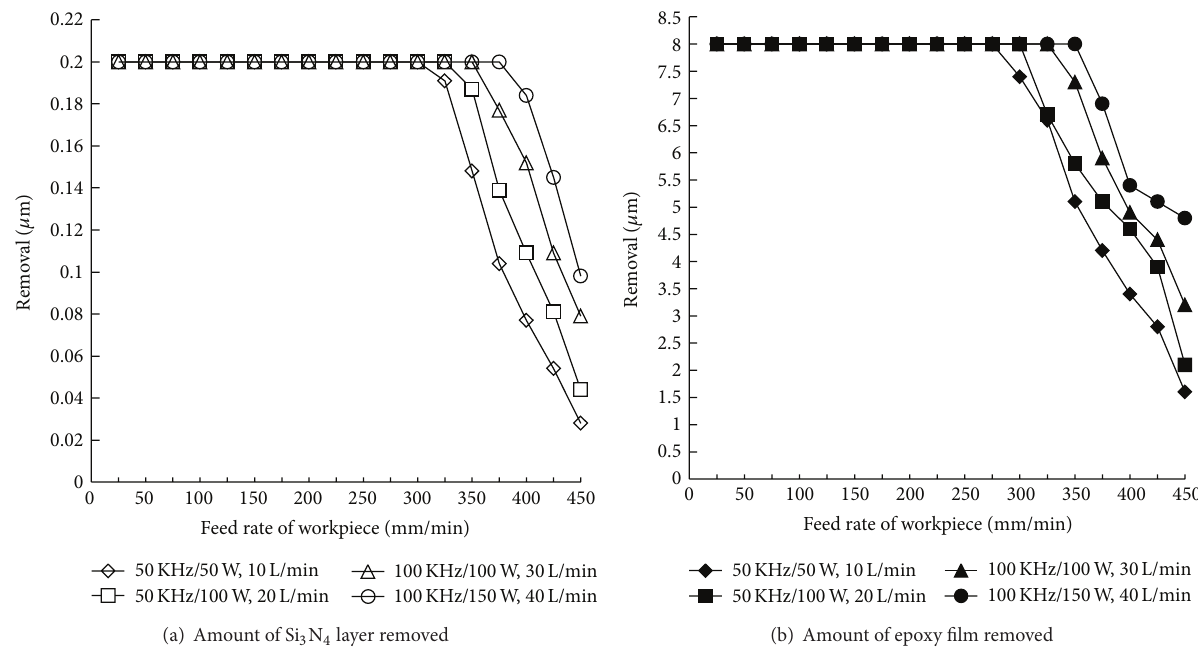
Figure 4: Amount of Si 3 N 4 layer and epoxy film removed using different combinations of frequency, ultrasonic power, and electrolyte flow rate (phosphoric acid, NaNO 3 15%wt, PO4-3-P 5% wt, 60 ∘ C, continuous DC, 150A, 80 V, 4000Gauss, shift 800 rpm, and tool